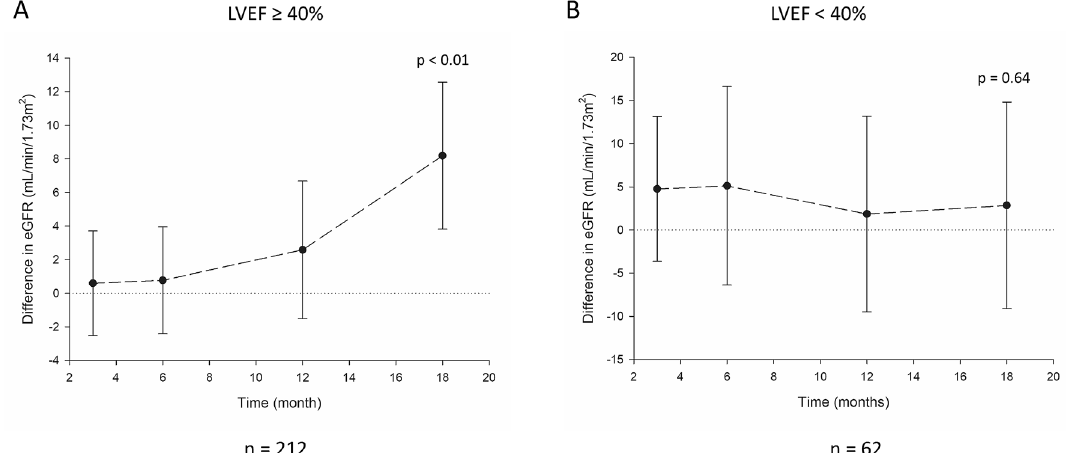
Figure 2. Difference of eGFR between patients on sacubitril/valsartan and valsartan stratified by LVEF. ( A ) LVEF ≥ 40% ( B ) LVEF < 40%. Difference of eGFR was calculated as sacubitril/valsartan group–valsartan group. eGFR, estimated glomerular filtration rate. P value calculated by generalized estimating equation.